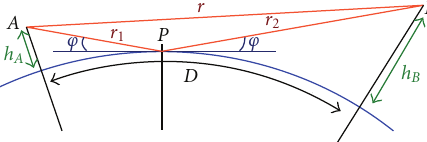
Figure 1: 2D geometry of the two-ray model.